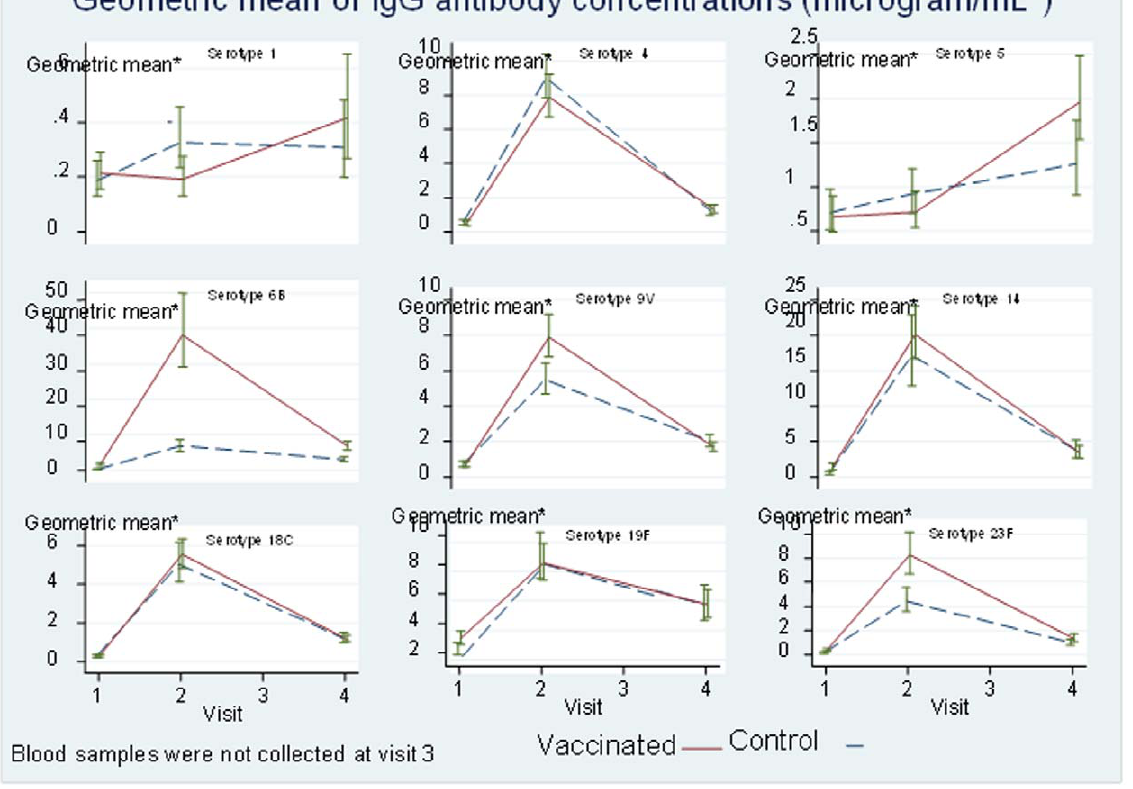
Figure 2. Geometric mean of IgG antibody concentrations ( m g/mL) before and after vaccination with PCV-7 in the two groups (visit 1=pre-vaccination). doi:10.1371/journal.pone.0031050.g002 Table 3. Nasopharyngeal carriage of Streptococcus pneumoniae before and after vaccination with a single dose of PCV-7.